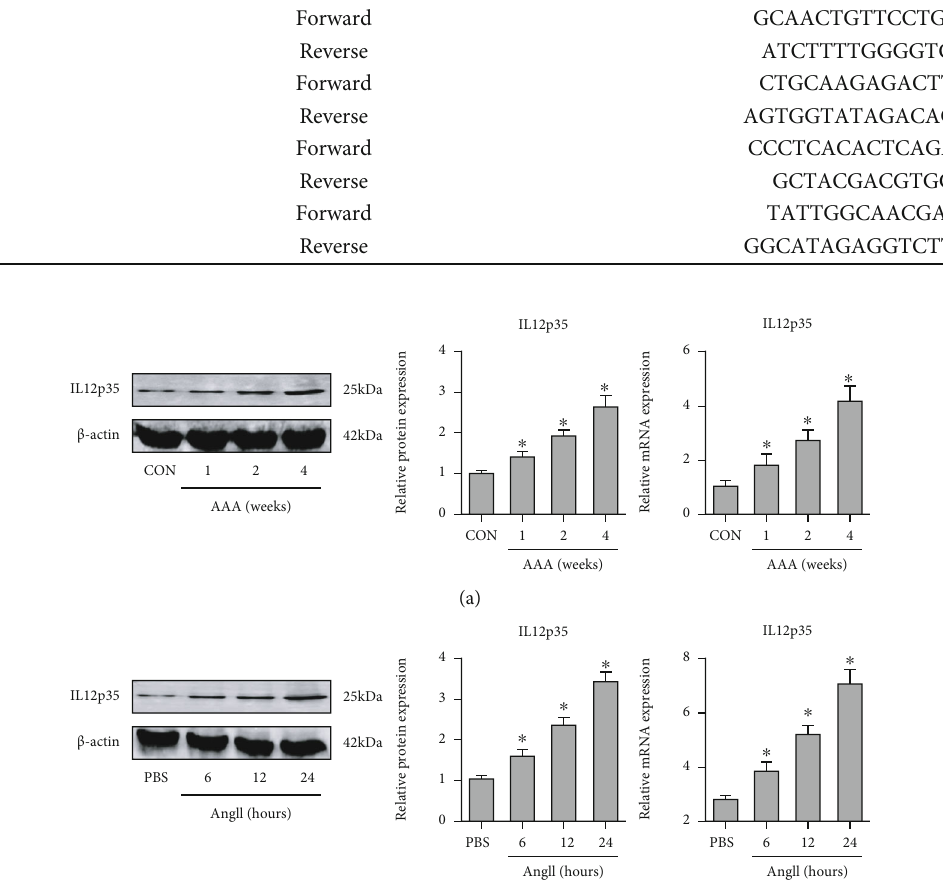
Figure 1: IL12p35 expression is increased in the murine AAA aorta and isolated aortic SMCs. (a) Western blots and PCR analysis of IL12p35 expression in murine aortic samples ( n = 5 per group). (b) Western blots and PCR analysis of IL12p35 expression in isolated aortic SMCs ( n = 5 per group). ∗ P < 0 : 05 , compared with the control or PBS group.